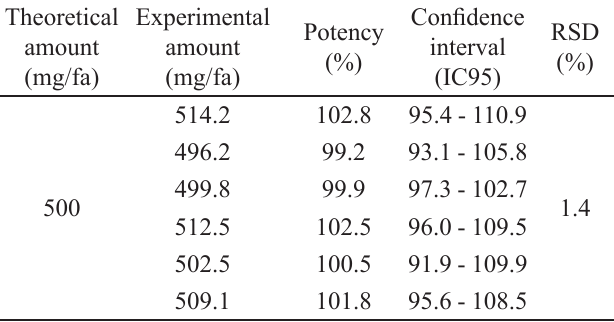
TABLE II – Results of the repeatability evaluation of the